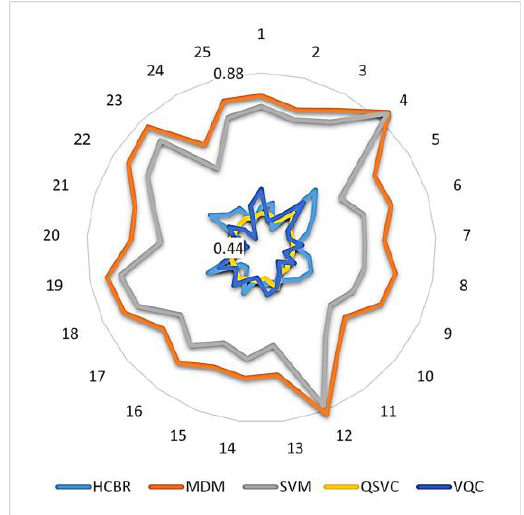
Figure 10. Intra-subject balanced accuracy of quantum and HCBR vs. SVM and MDM classifiers. The numbers around the circle indicate each participant. Accuracies are displayed on a logarithmic scale from 0.44 to 0.88.